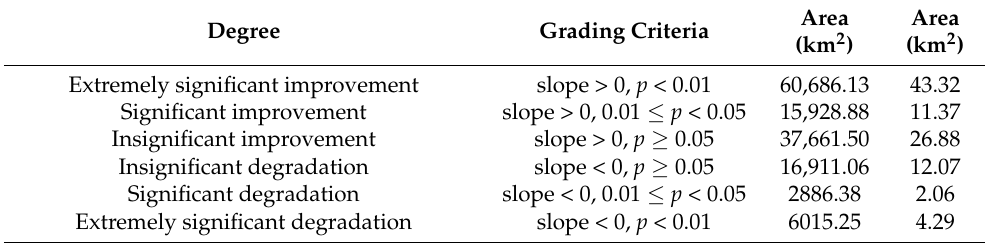
Table 1. Significant statistical results of variation trend of NDVI in Anhui